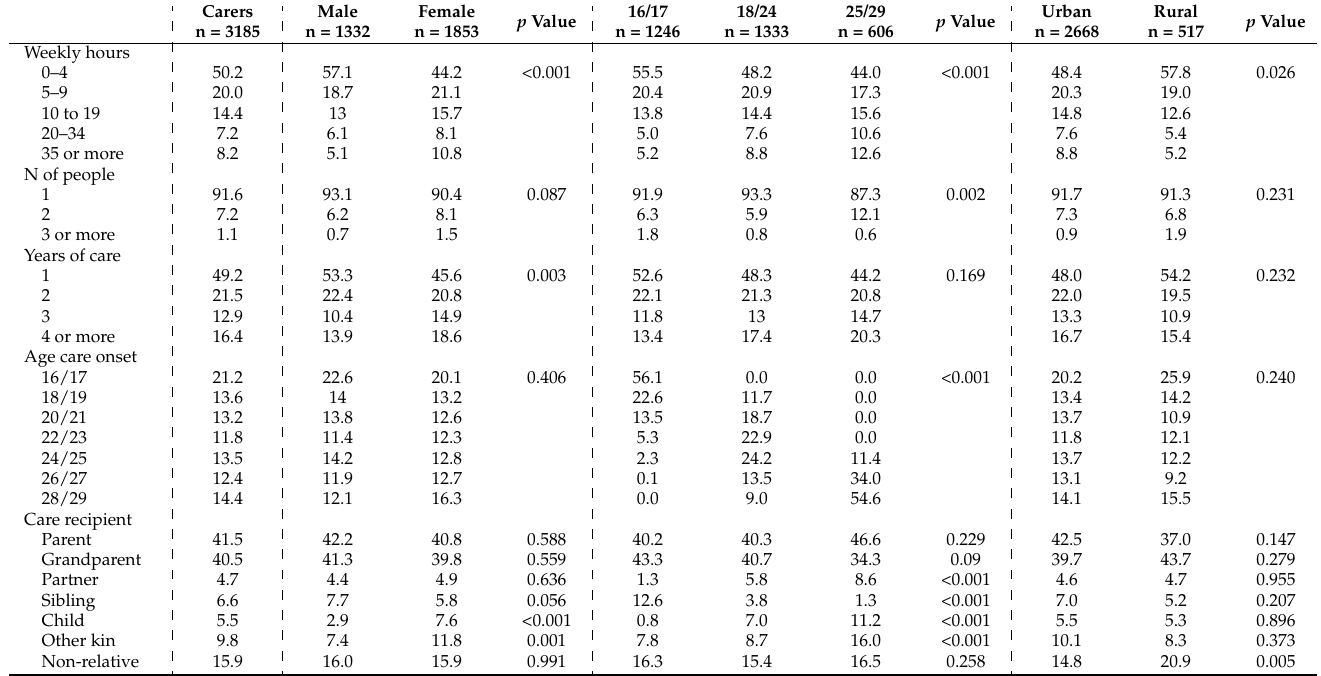
Table 3. Percent caregiving characteristics among carers by sex, age groups, and